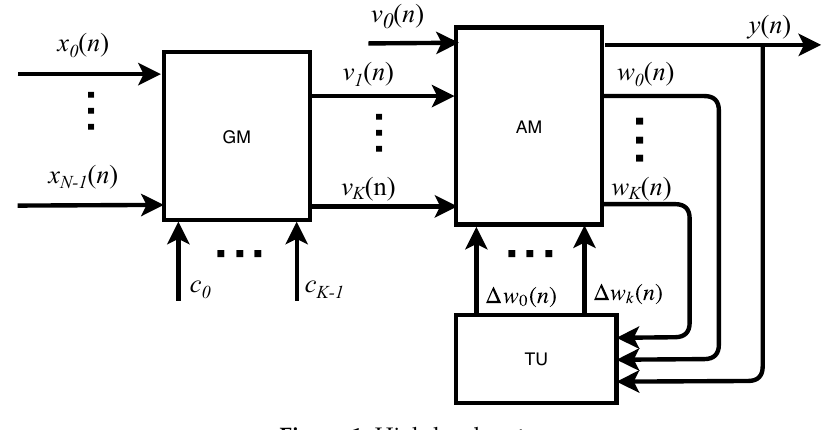
Figure 1. High-level system.